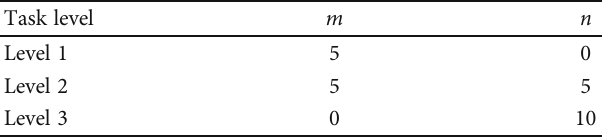
Table 2: Values of m and n under di ff erent task levels.